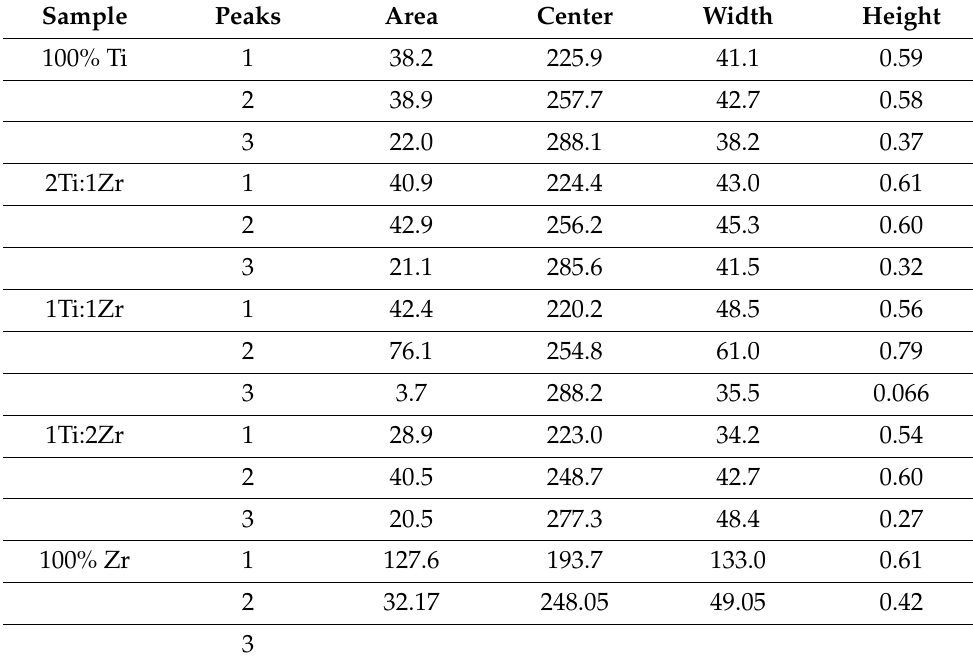
Table 5. Deconvolution data of diffuse reflectance spectra.